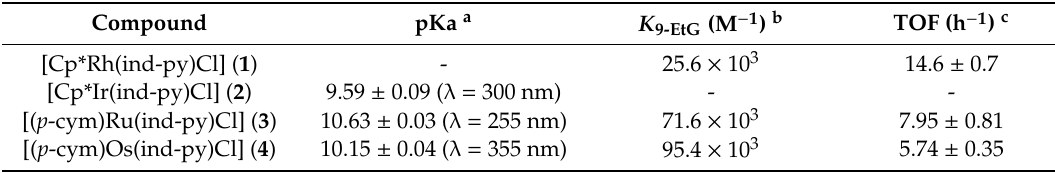
Table 1. Reactivity of complexes 1 – 4 . a pKa values measured using UV-Vis spectroscopy, solvent 6% acetonitrile / water v / v . b Binding constants towards 9-EtG, concentration of complex 1.1 mM in MeOD / D 2 O (1:1 v / v ). c Turnover frequencies for the reduction of NAD + (9 mol. equiv.) using